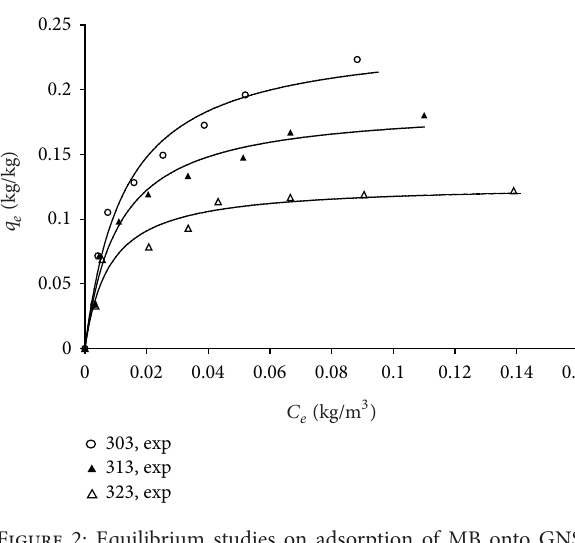
F 2: Equilibrium studies on adsorption of MB onto GNSP.